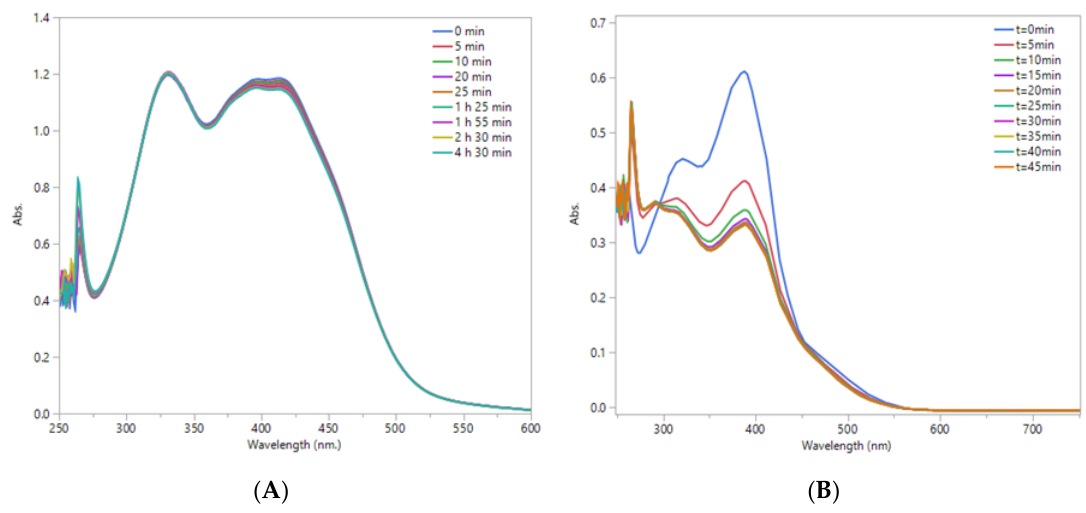
Figure 6. UV/Vis Absorption changes upon irradiation of visible light. From left to right, ( A ) AZO1 and ( B ) AZO2 absorption spectra.